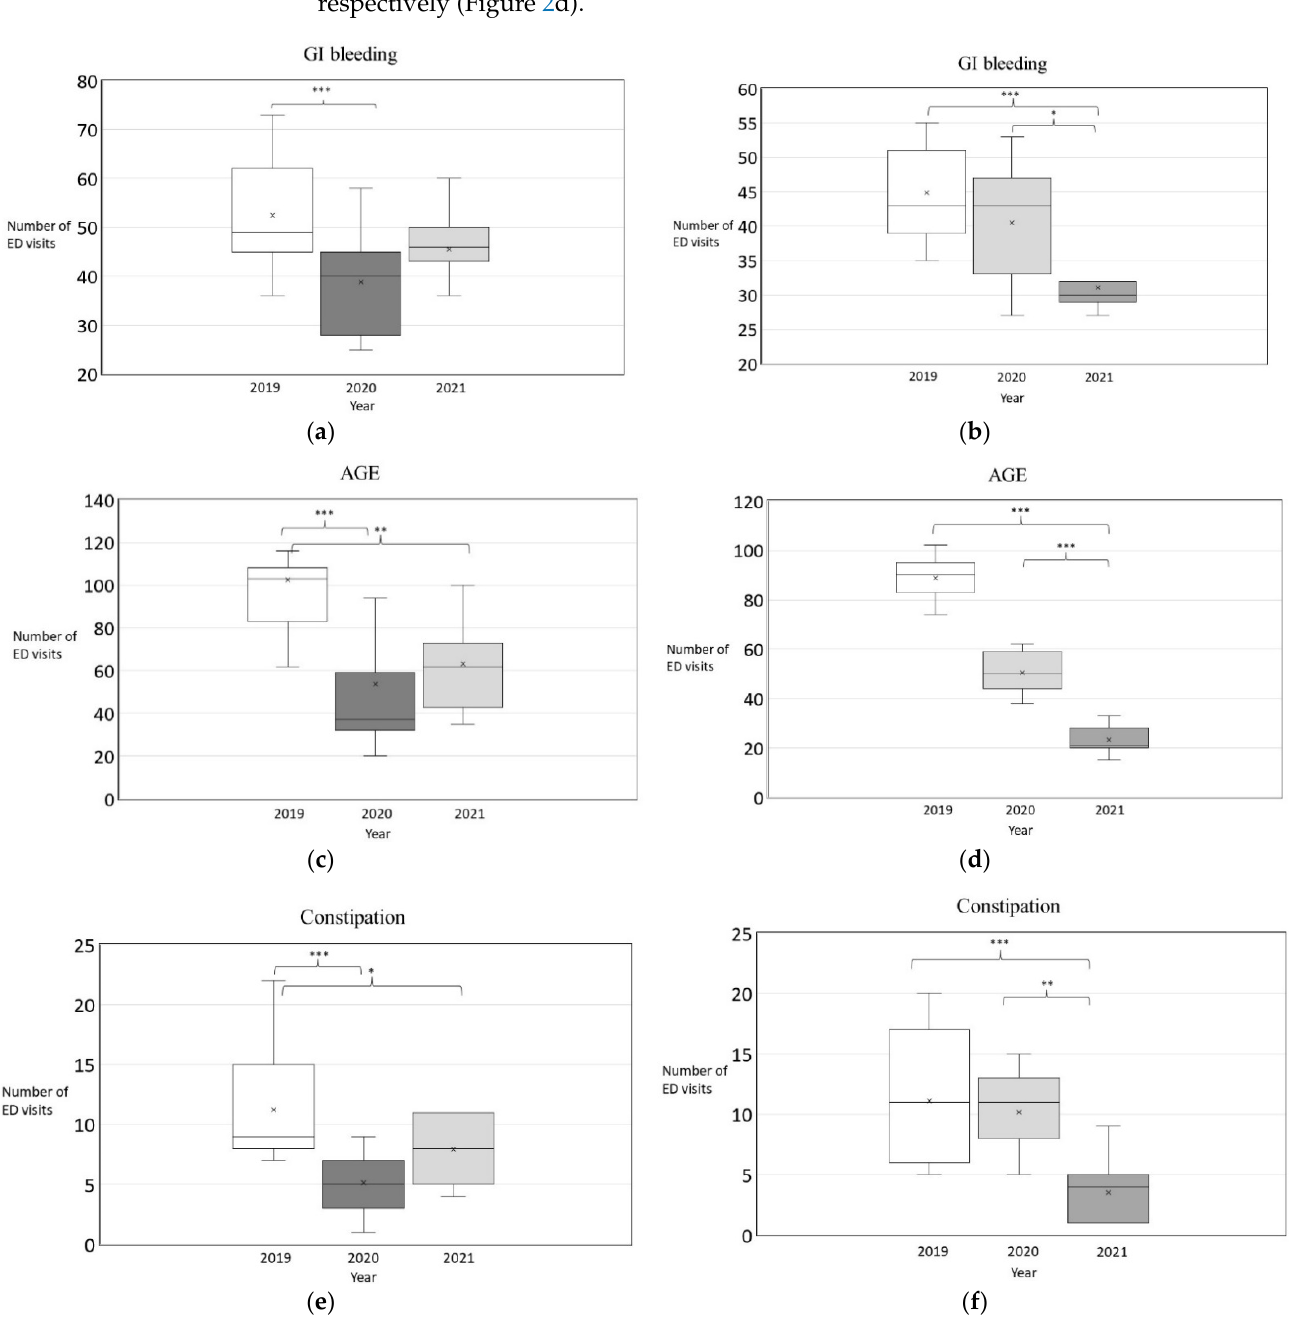
Figure 2. Boxplot of emergency department visits for ( a ) GI bleeding in period 1, week 4–18, ( b ) GI bleeding in period 2, week 21–31, ( c ) AGE in period 1, week 4–18, ( d ) AGE in period 2, week 21–31, ( e ) constipation in period 1, week 4–18, and ( f ) constipation in period 2, week 21–31. Note: Baseline period in white, peak pandemic period in dark gray, slack period in light gray. The x indicates the mean. * p < 0.05, ** p = 0.001, *** p < 0.001.